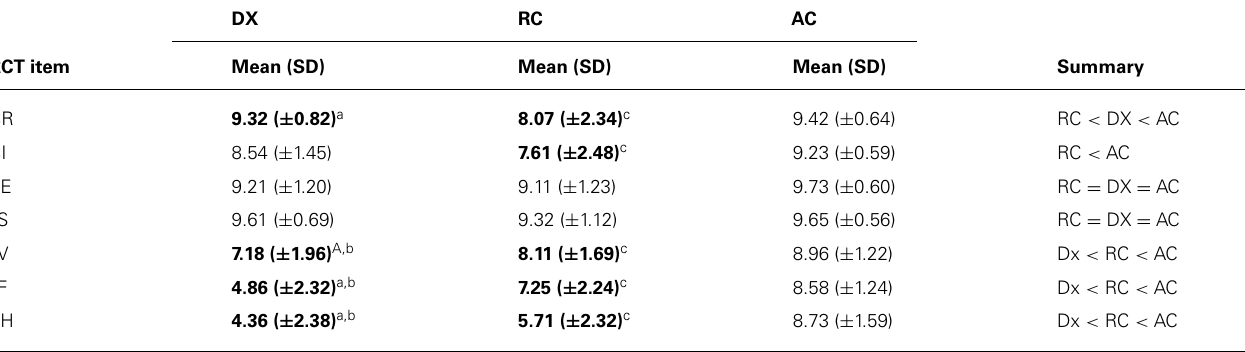
Table 2 | Mean number of correct responses and standard deviation (SD) of the three groups on the seven subitems of the